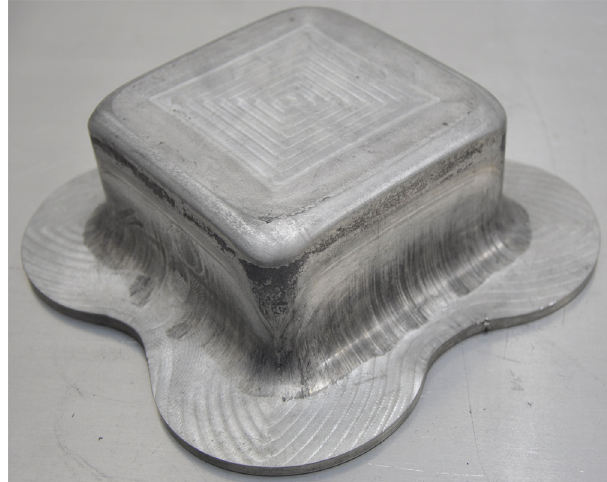
Fig. 5. A manufactured hot stamped square cup by employing the Thickened plate 2.